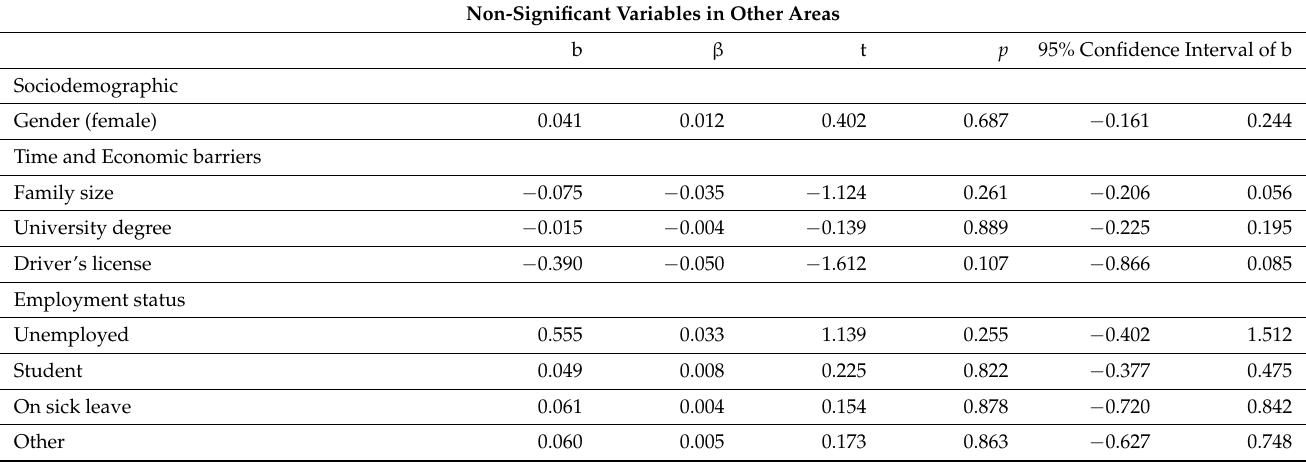
Table A2. Non-significant variables during regression analysis of perceived accessibility to public transport in other cities ( N =